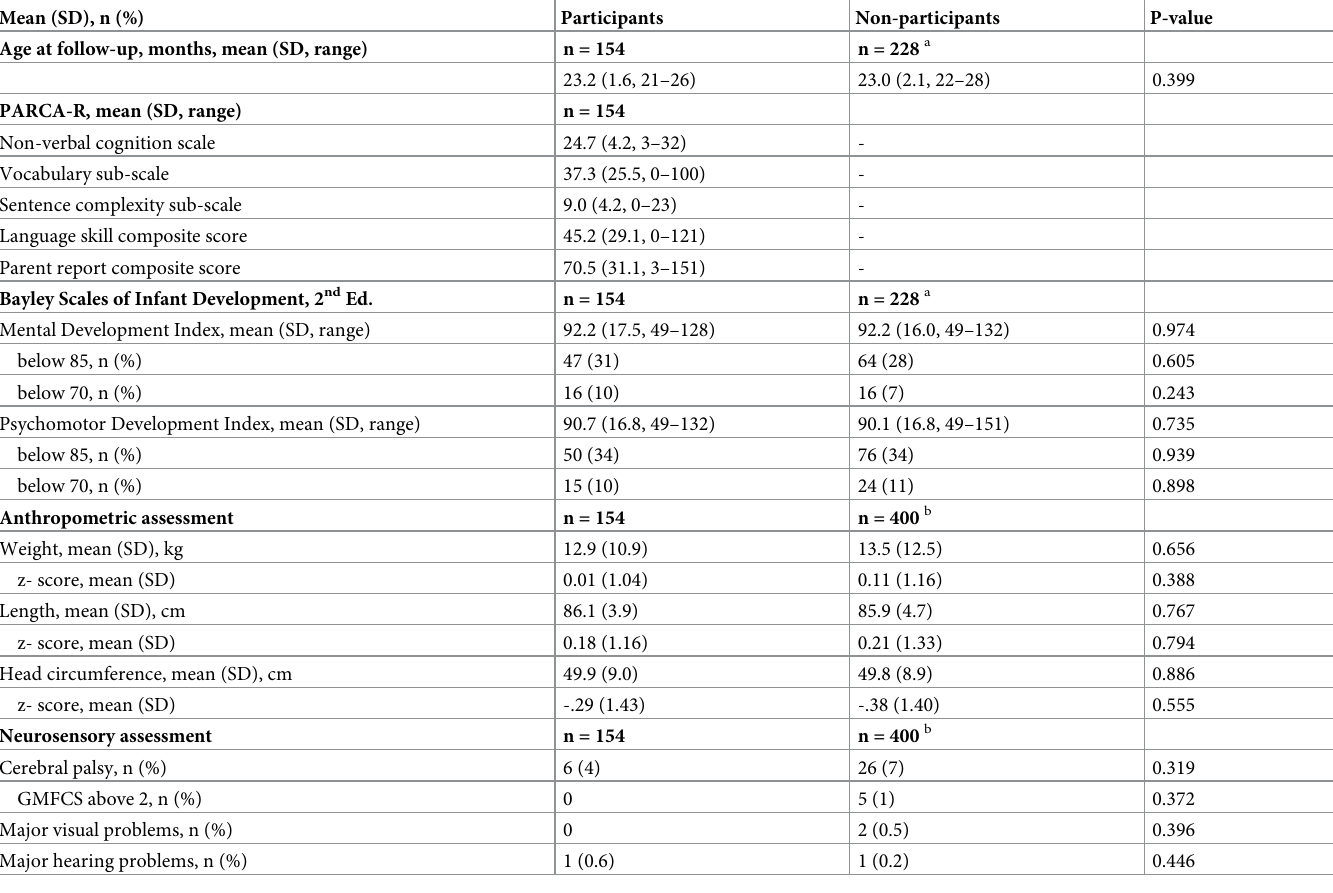
Table 1. Neurodevelopmental measurements at 2 years of corrected age (PARCA-R screening and clinical examination) of the study participants and of non-partic- ipants infants (total n =